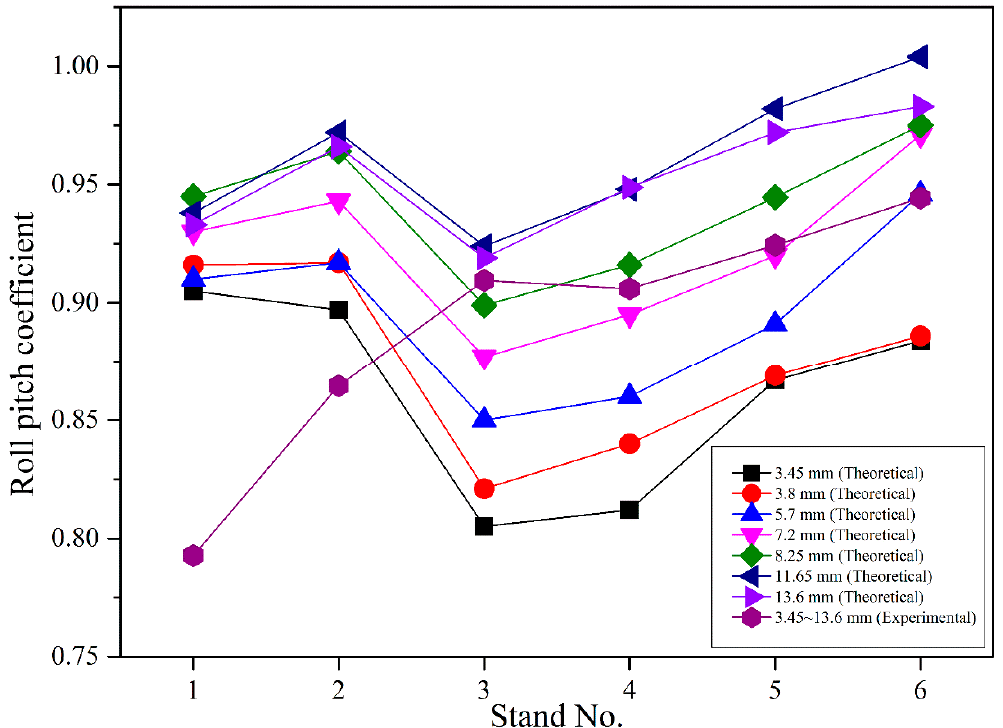
Figure 14. Comparison of theoretical and initially used experimental pitch coefficients.